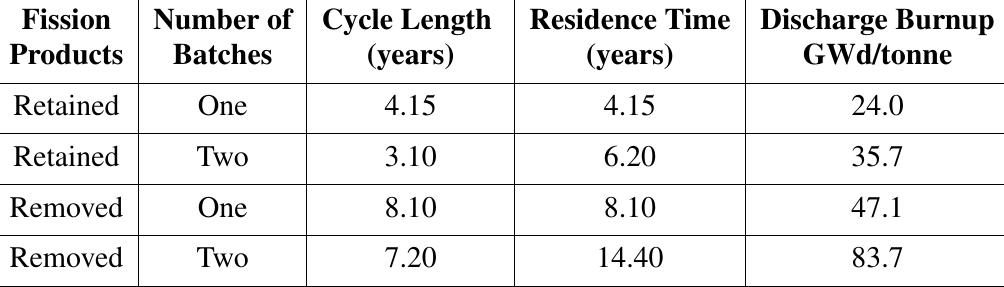
Table II: Preliminary multibatch modelling